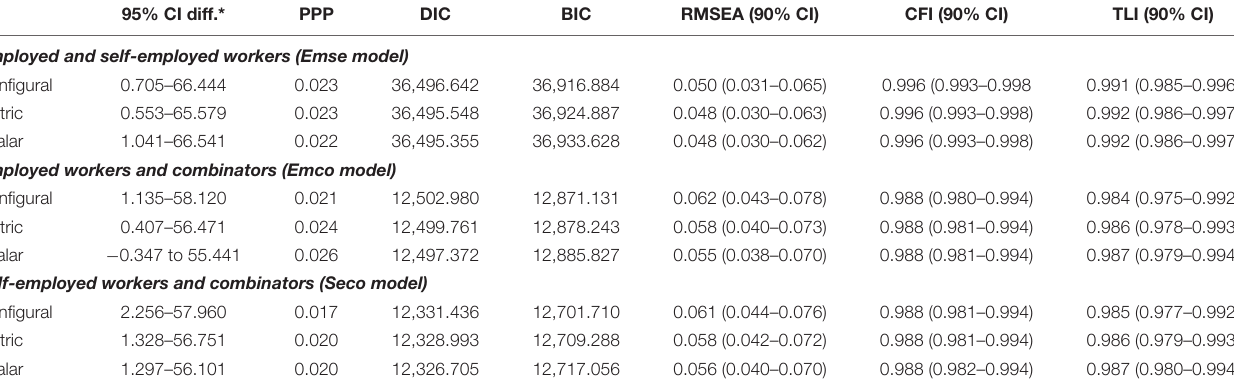
TABLE 5 | Measurement invariance analyses: Emotional exhaustion.